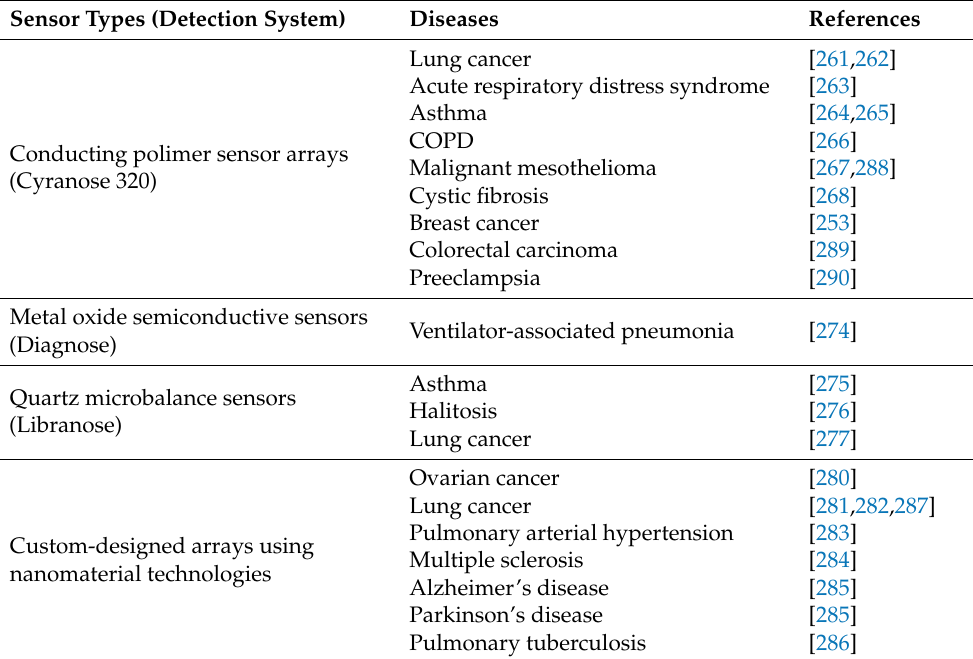
Table 4. Representative examples for medical utilization of different electronic nose sensor